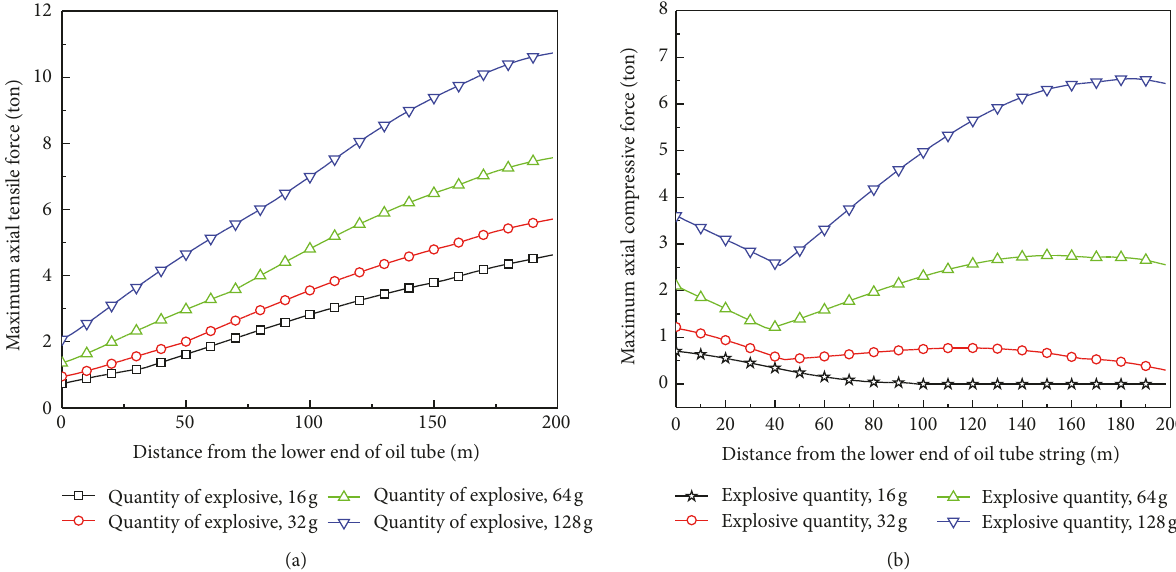
Figure 15: Effect of charge quantity on the maximum compressive force in oil tube string: (a) tensile force; (b) compressive force.